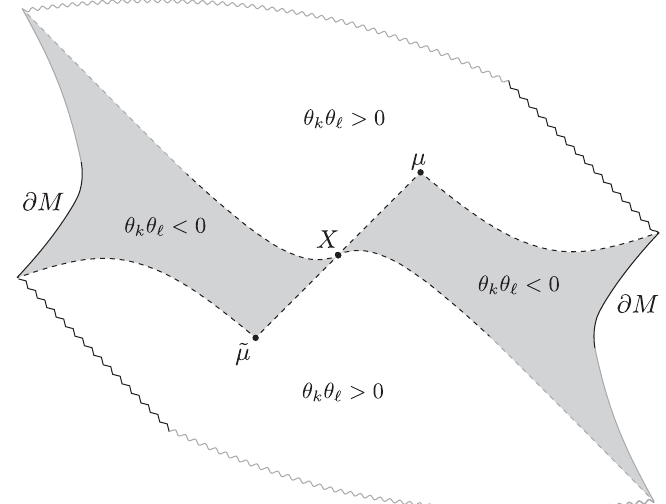
Figure 3. Black lines show numerically computed features of a coarse-grained spacetime formed from a marginally trapped (minimar [48]) surface µ on the spacelike section of the holographic screen shown figure 2. Dashed lines represent apparent horizons, while X is the HRT surface. Grey lines lie outside the range of our numerics, and are pure sketches representing a qualitative image of how the full spacetime could look like. For an illustration with additional details, see figure 4 in the